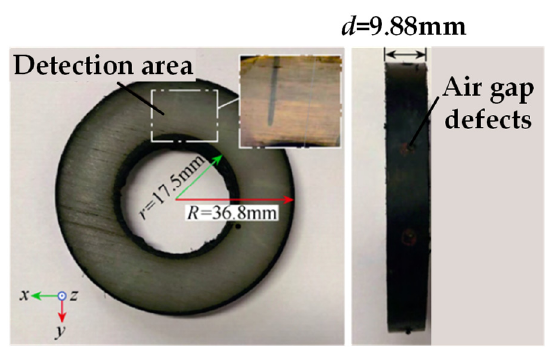
Figure 18. XLPE samples for experimental use [74].